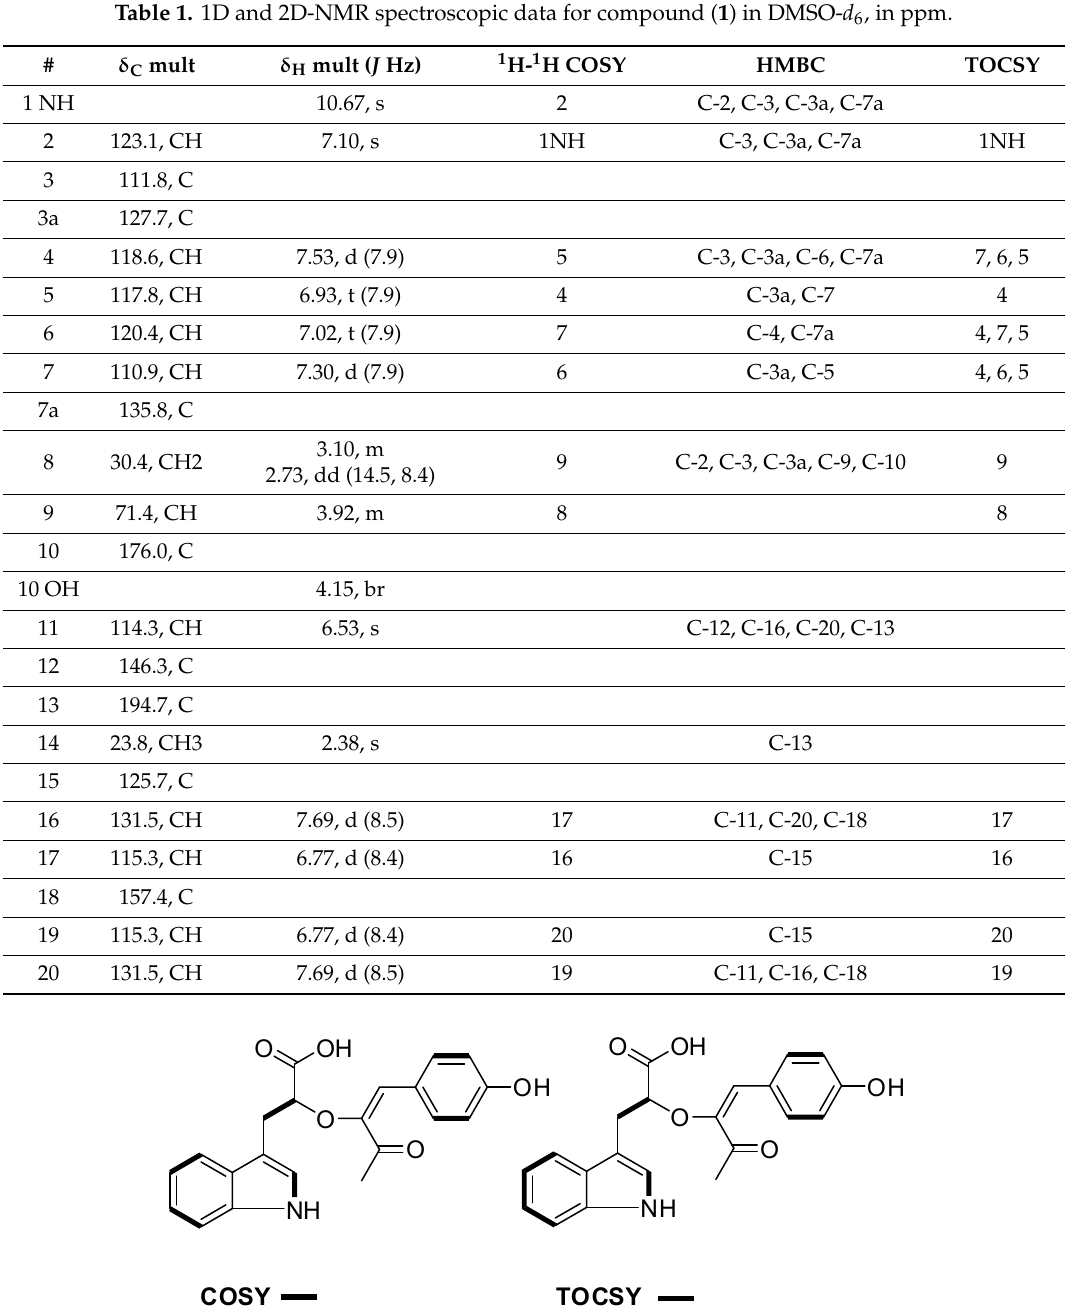
Figure 2. Key COSY and TOCSY correlations (bold lines) show all the spin systems present in compound 1 .